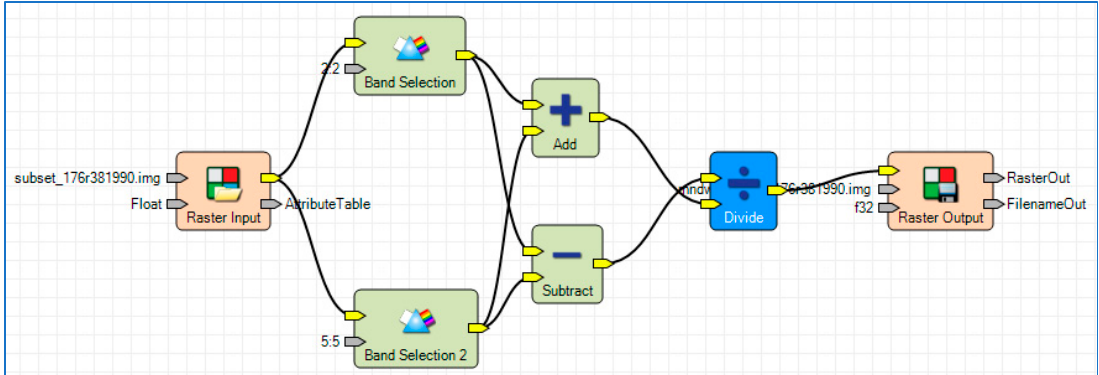
Figure 4. ERDAS Imagine model maker interface used to calculate NDWI/MNDWI.